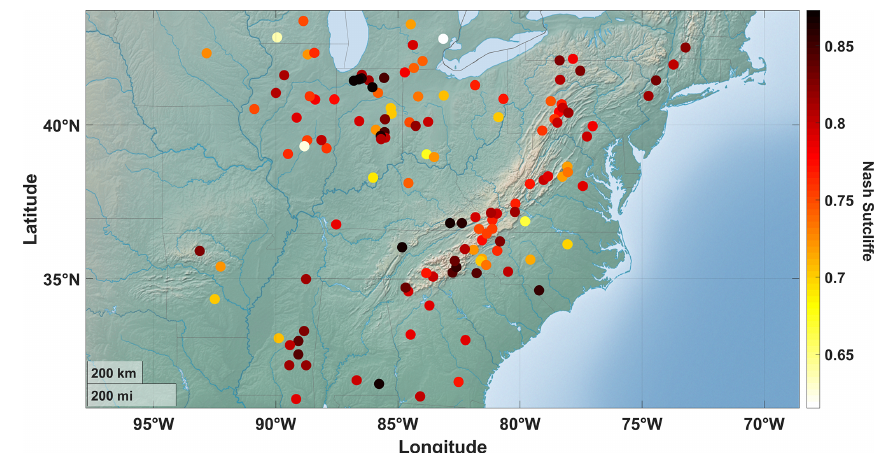
Figure 2. Nash–Sutcliffe efficiency (NSE) calibration results for all catchments.